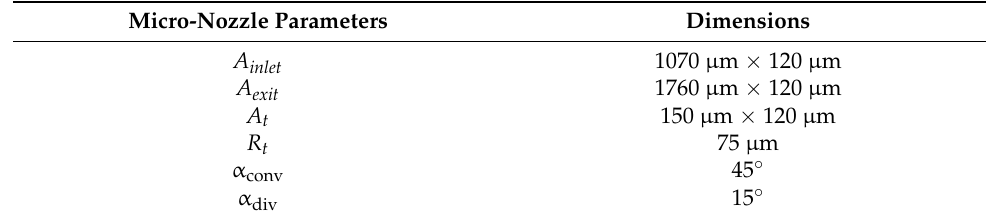
Table 1. Micro-nozzle geometry and dimensions.